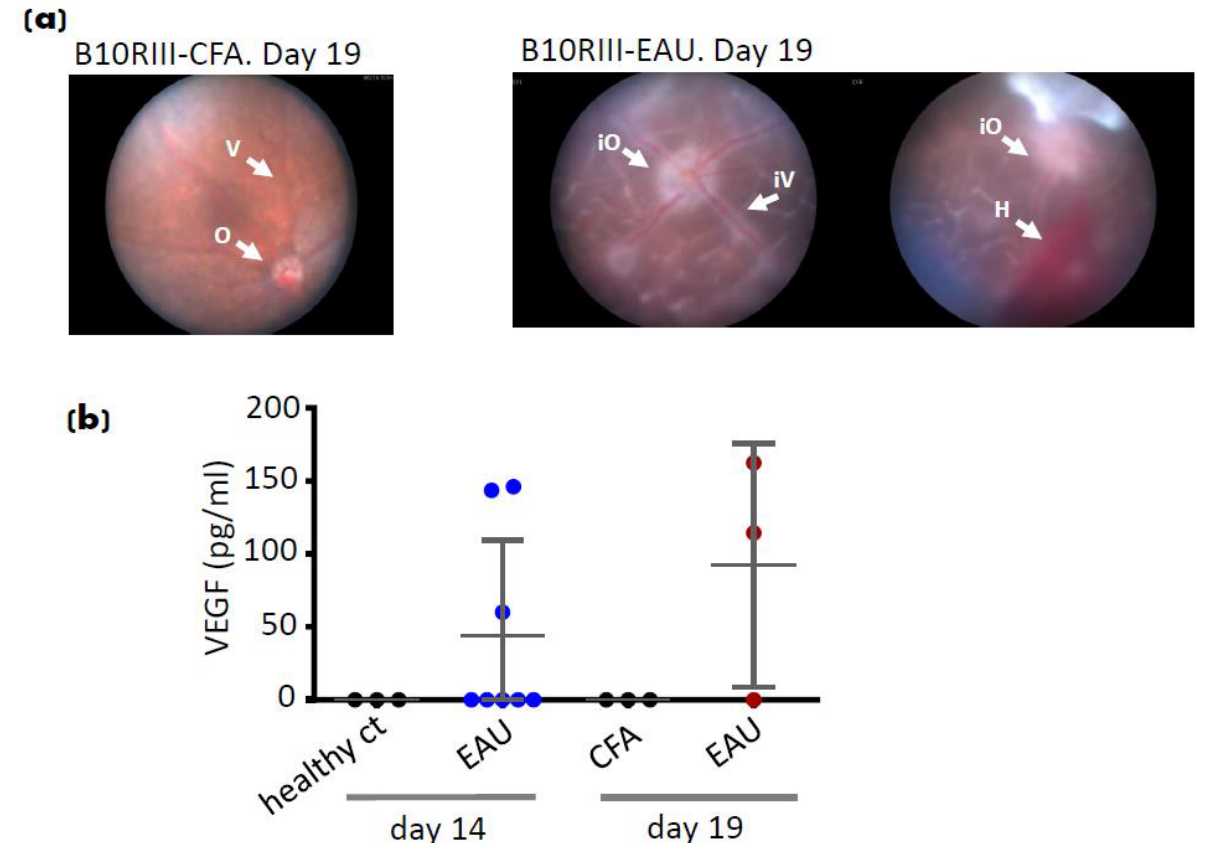
Figure 1. Vascular endothelial growth factor (VEGF) detection in experimental autoimmune uveitis (EAU). ( a ) . Fundoscopy on B10RIII EAU mice on day 14 and 19 and ( b ) VEGF levels (pg/mL) detected in vitreoretinal fluids from healthy control and EAU eyes on days 14 and CFA (Complete Freund’s Adjuvant) control and EAU eyes on day 19. Data are representative of at least 4 independent experiments with different numbers of mice ( n = 3–6) in each group. ct = control, O = optic disk, V = vessel, iO = inflamed optic disk, iV = inflamed vessel, H =